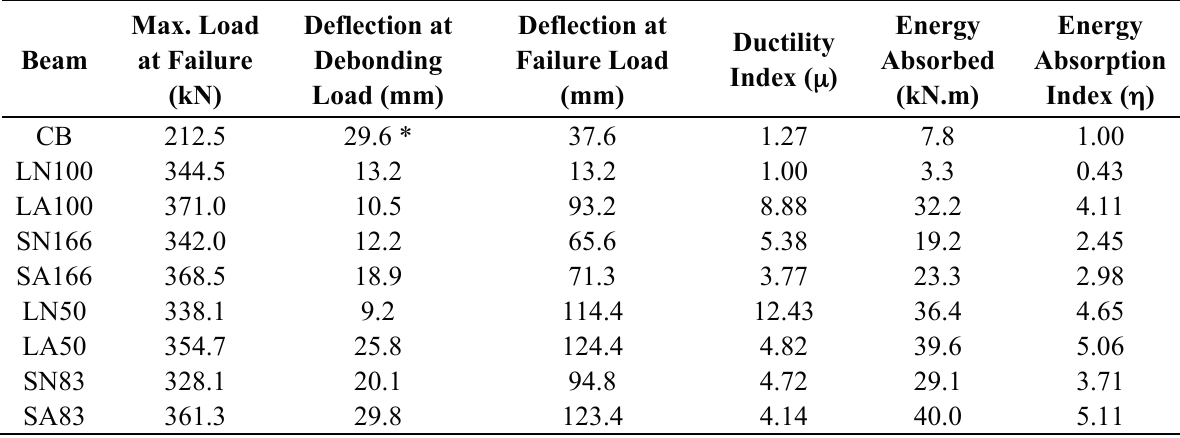
Table 5. Deflection, ductility and energy absorption of the test